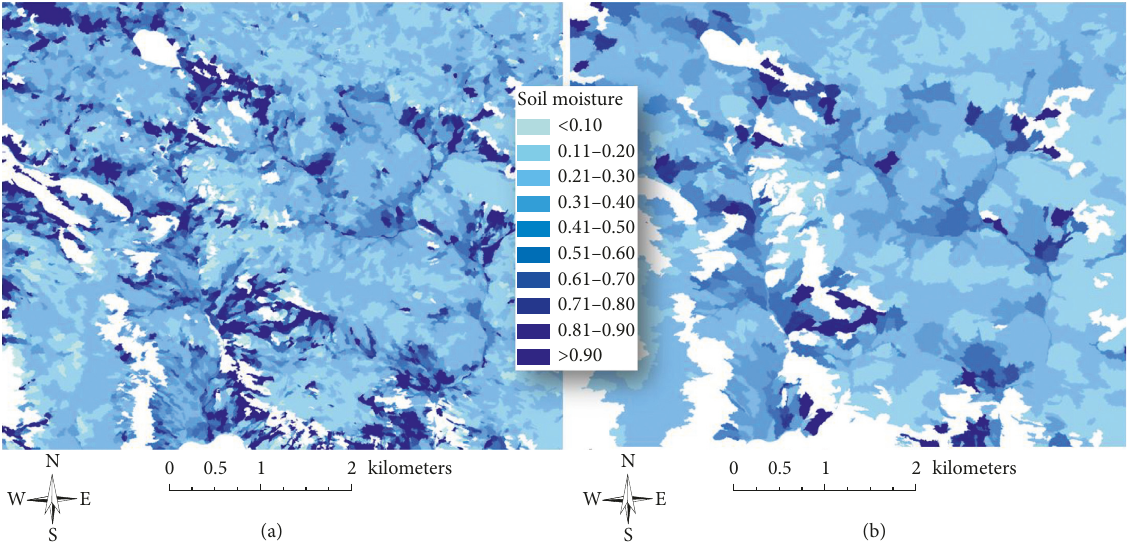
Figure 10: Comparison of ANN-modelled soil moisture for small (a) and large (b) image objects. Values shown are for July 11, 2010.